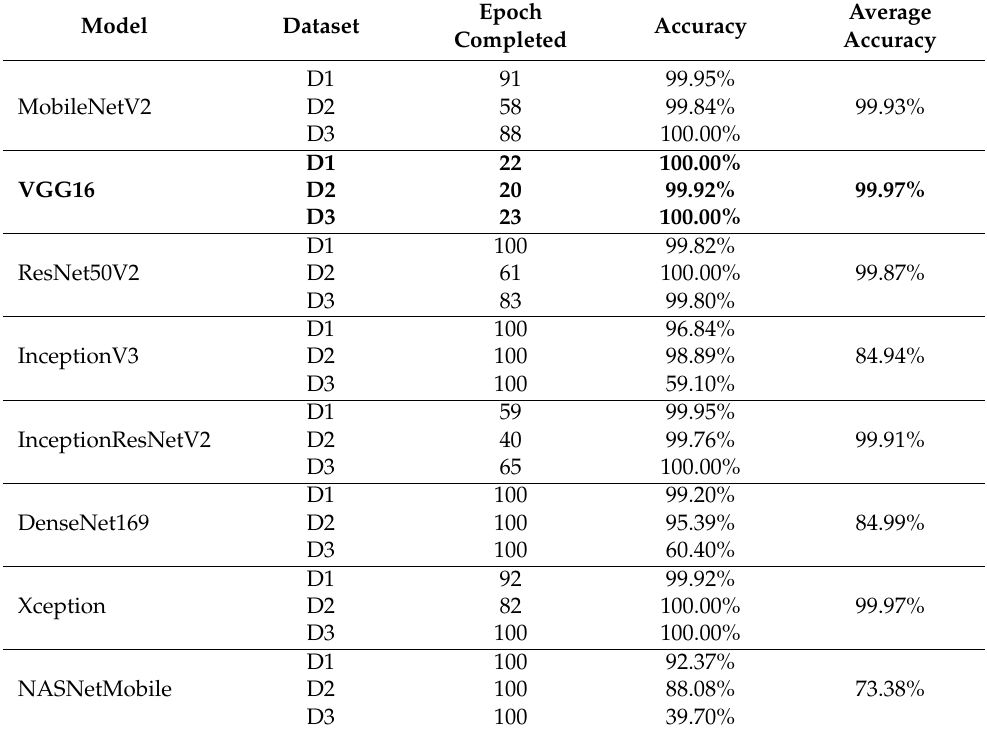
Table 3. Results of the pre-work for feature extractor selection.